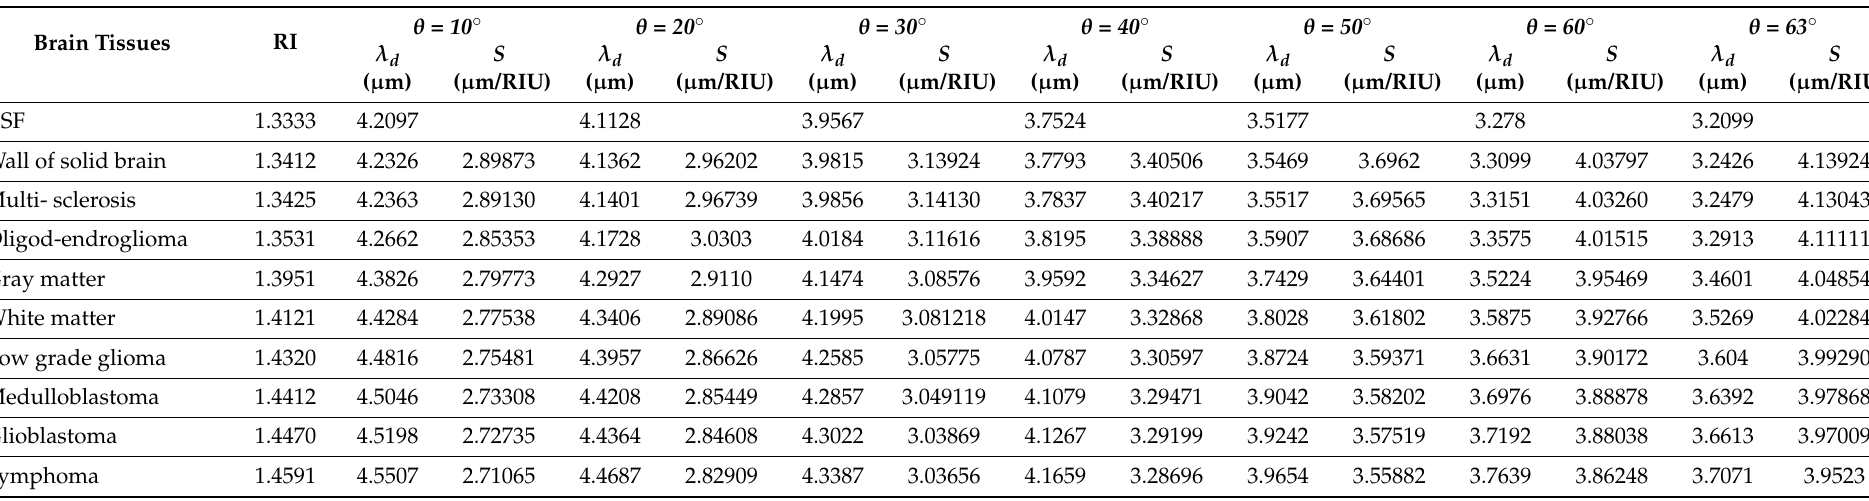
Table 2. The performance evaluation table presenting defect mode wavelength ( λ d ) and senstivity ( S ) of the proposed design corresponding to different